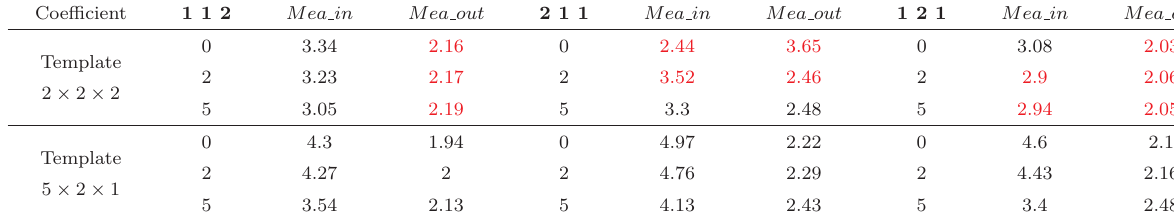
Table 3 Measurements of aspect enhancement experiment